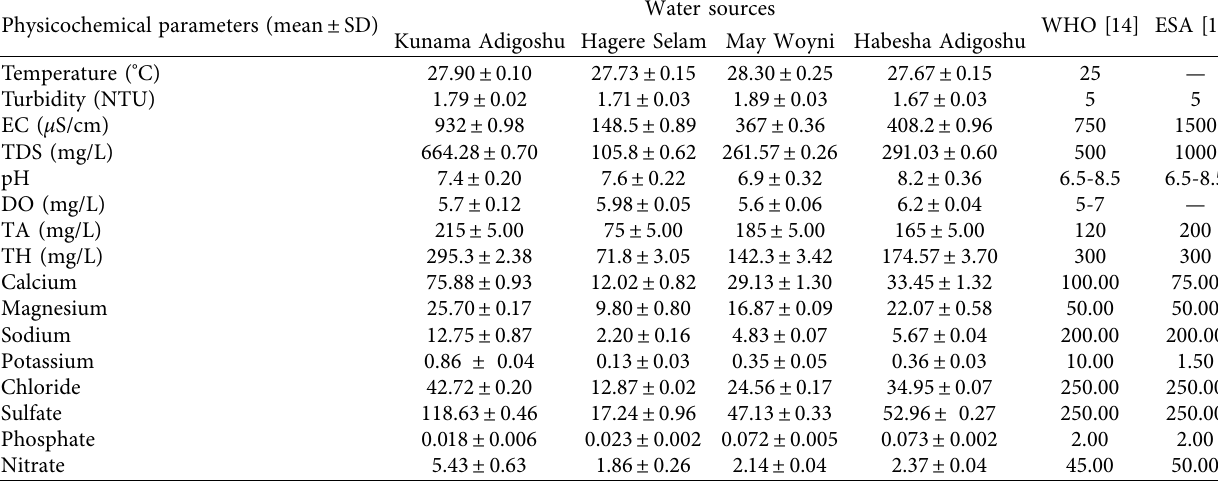
Table 1: The physicochemical parameter concentrations (mean ± SD, N � 3) of hand-dug well samples of Kafta Humera Woreda. Physicochemical parameters (mean ± SD)